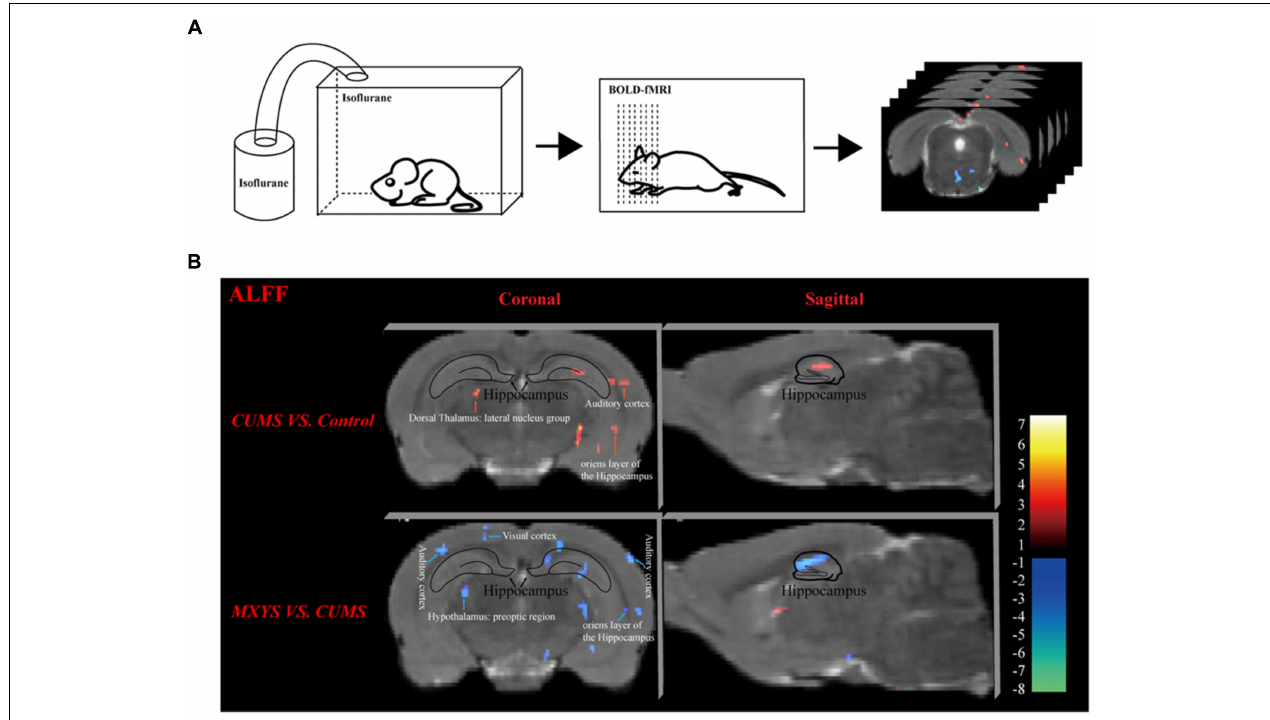
FIGURE 2 | Effect of MXYS on BOLD–fMRI signal in brain regions of mice. (A) Schematic representation of the process for fMRI experiment. (B) Images of coronal and sagittal planes show the changes of BOLD–fMRI signal in the hippocampal region between different groups according to the results of the ALFF analysis. The voxel-level height threshold was P < 0.005 (uncorrected) and the cluster-extent threshold was 20 voxels.